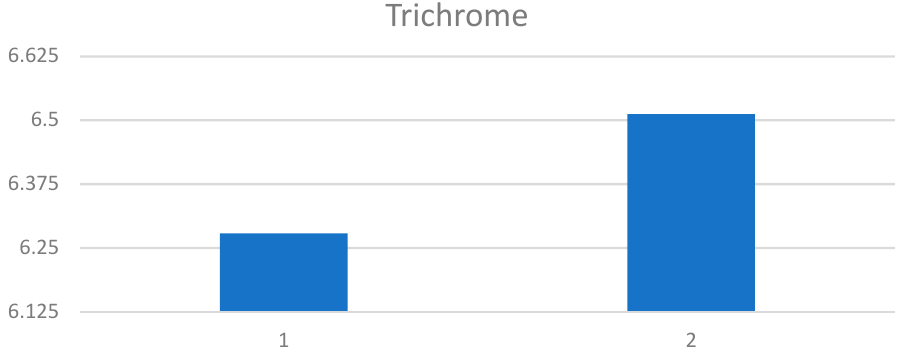
Figure 7. Visualization of the differences in collagen concentration before and after treatment (computer program IMAGEL).